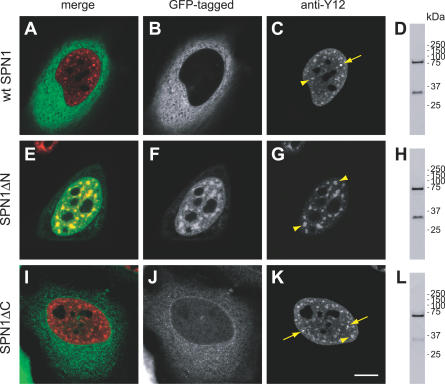
A Deletion Variant of Snurportin 1 Affects the Subnuclear Distribution of snRNPsHeLa cells were transfected with either wt snurportin1 (wt SPN1) (A–D) or the deletion variants SPN1ΔN (E–H), and SPN1ΔC (I–L) fused to GFP. The cells were labeled with mAb Y12 directed against Sm proteins.(A,E,I) Depict the superimposition of red (Y12 antibody staining) and green (GFP-tagged protein) images.(B,C,F,G,J,K) Depict the same cell imaged for GFP-tagged protein and Y12 staining, as indicated; arrows point to CBs and arrowheads to nuclear speckles. Bar indicates 10 μm. (D,H,L) Show the western blot analysis of each fusion protein. Molecular weight markers (kDa) are indicated on the left.